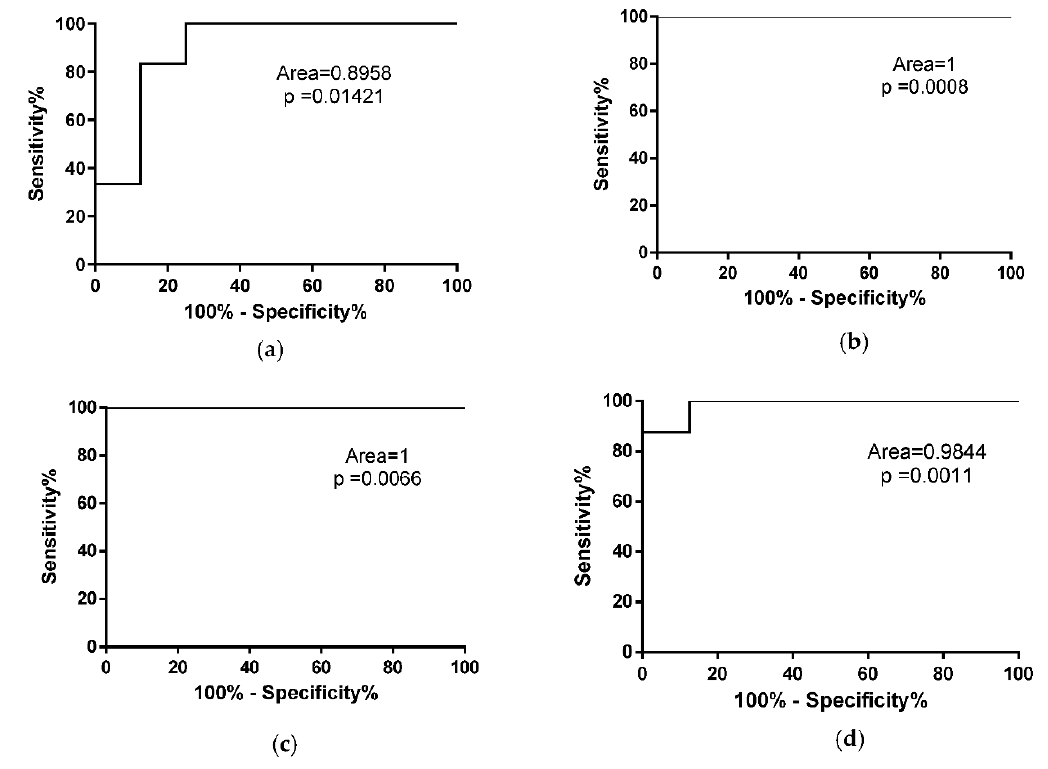
Figure 6. miR-133a is a biomarker for symptomatic ALS mice. ROC curve analysis of miR-133a levels in WT mice compared to SOD1 G93A high-copy mice at ( a ) early stage and ( b ) end stage of the pathology. ( c , d ) ROC curve analysis of miR-133a in WT mice compared to SOD1 G93A low-copy mice at late stage ( c ) and end stage ( d ) of the disease.